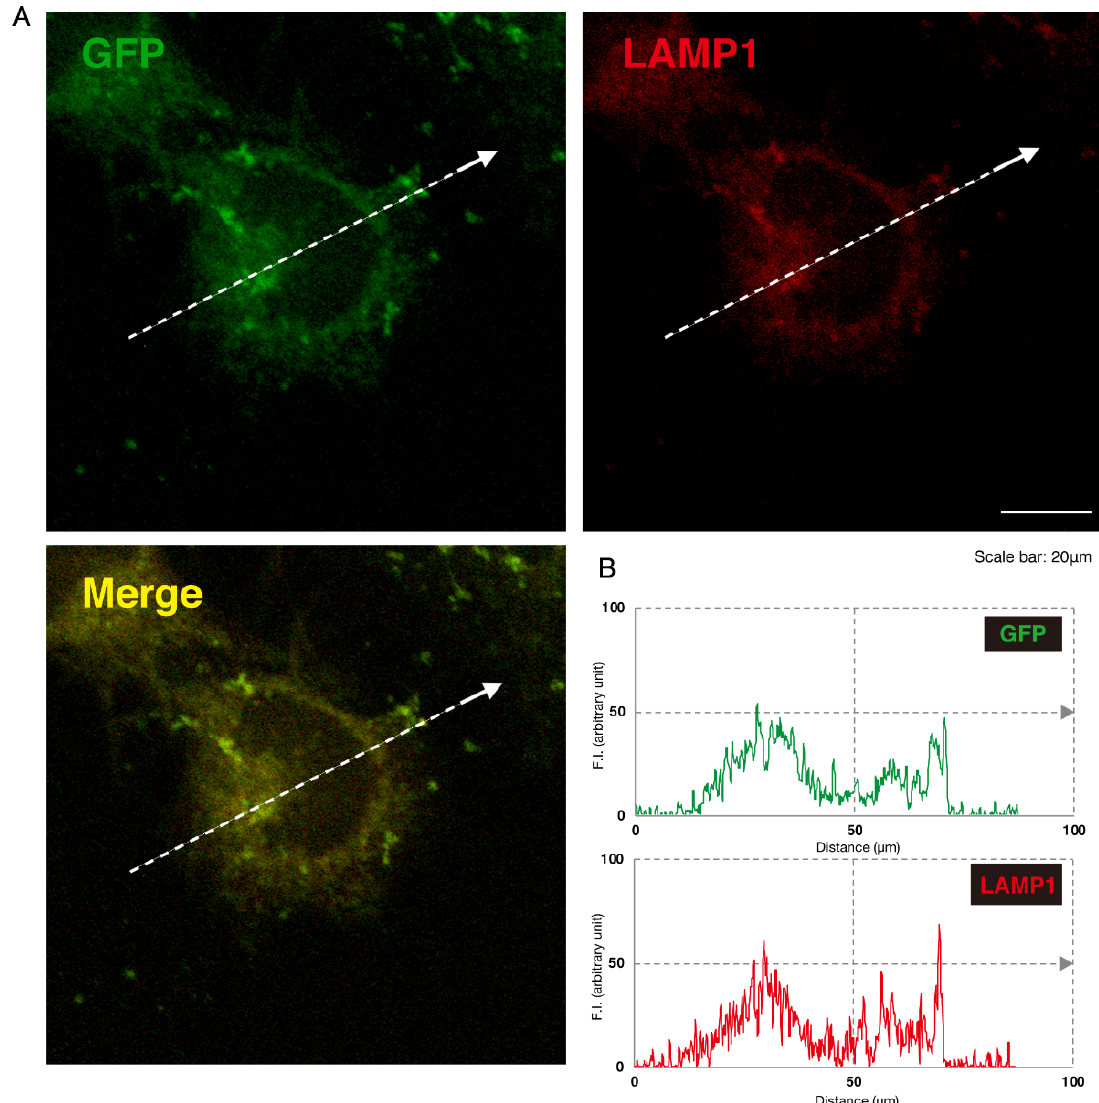
Figure 7. The Q39X mutant proteins are not present in the lysosome marker. ( A ) N1E-115 cells were transfected with the plasmid encoding the Q39X mutant construct of GFP-tagged AIMP1 (green). Transfected cells were stained with an antibody against the lysosome marker LAMP1 (red). A merged image with a dotted arrow is also shown in the bottom panel. The scale bar indicates 20 μ m. ( B ) Fluorescence intensities (F.I., arbitrary unit) of green and red colors are shown along the dotted arrows in A.